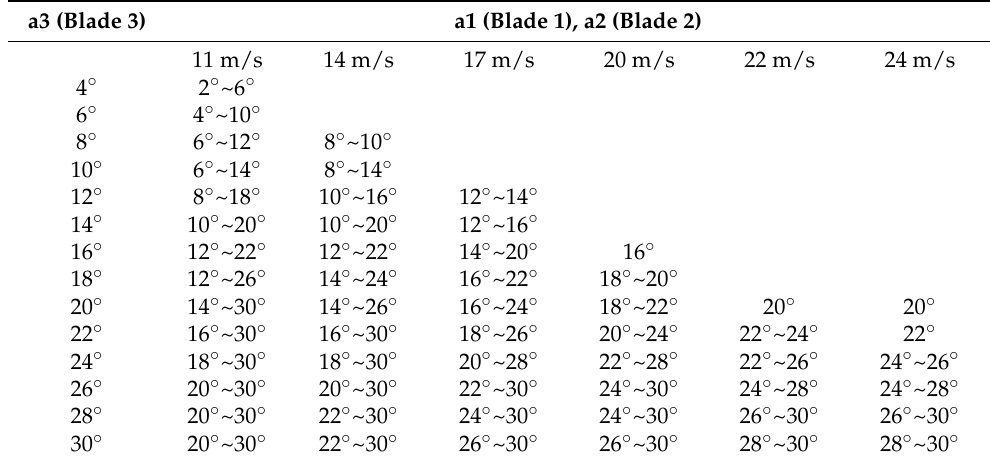
Table 5. Approx. APA region for M a .